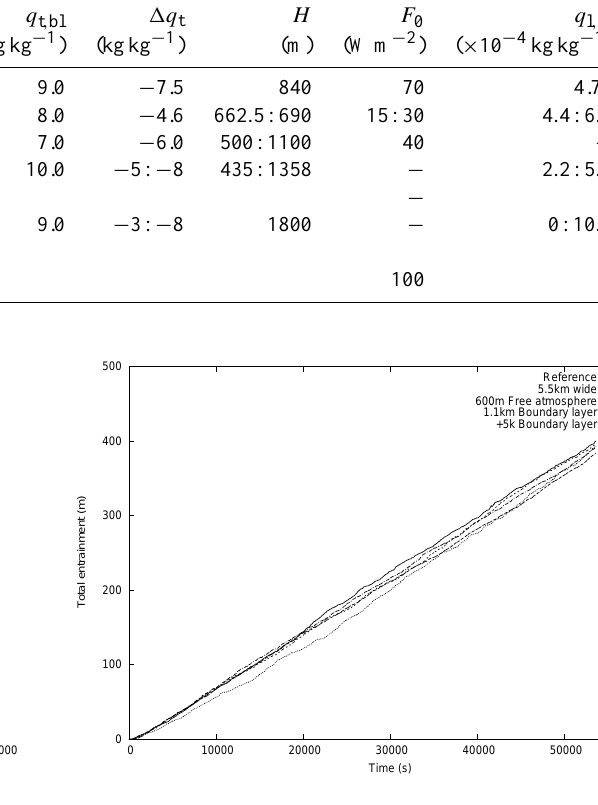
Fig. 5. Total entrainment against simulated time for executions of the wrapped ERM with different geometries and different boundary layer